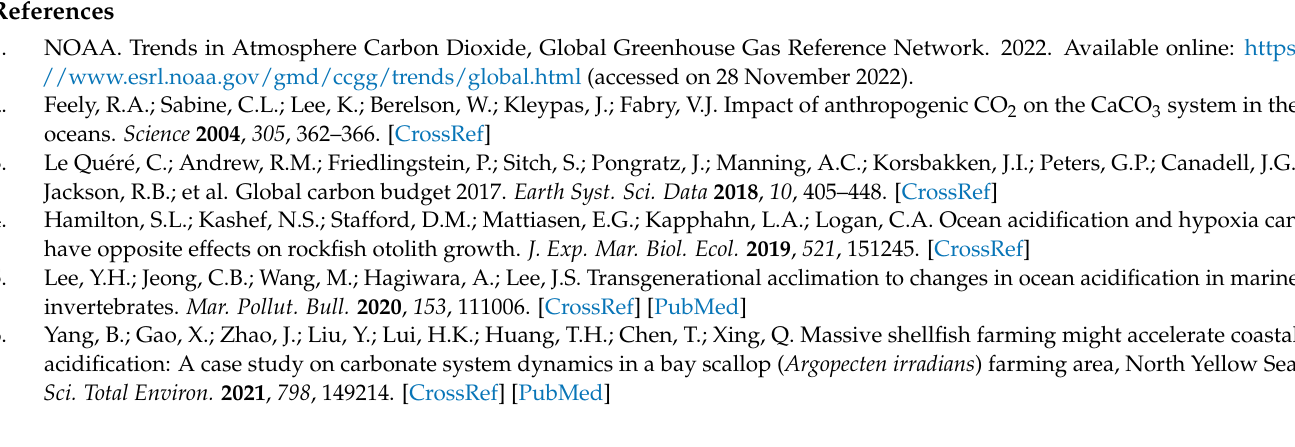
Figure A8. The contribution of photosynthesis, microbial respiration, coral metabolism and air–sea exchange to inorganic carbon dynamics ( a – e ) of the reef area of Yangmeikeng Sea Area (Area I) and Dalu Bay (Area Ⅱ ) in the in November.